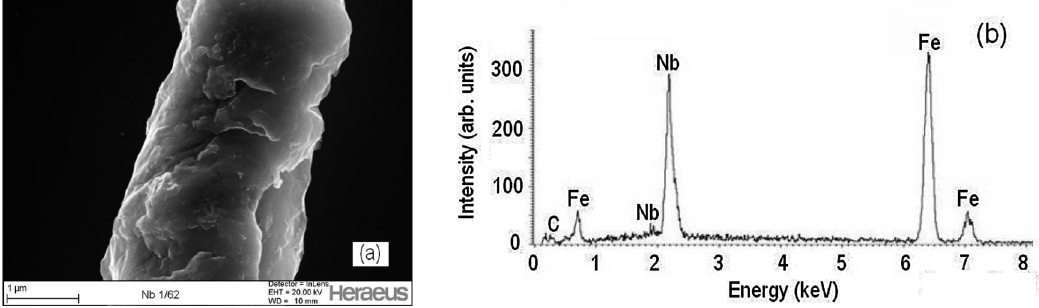
FIG. 4. (a) SEM image of the foreign material inclusion; (b) EDX element analysis of the image of